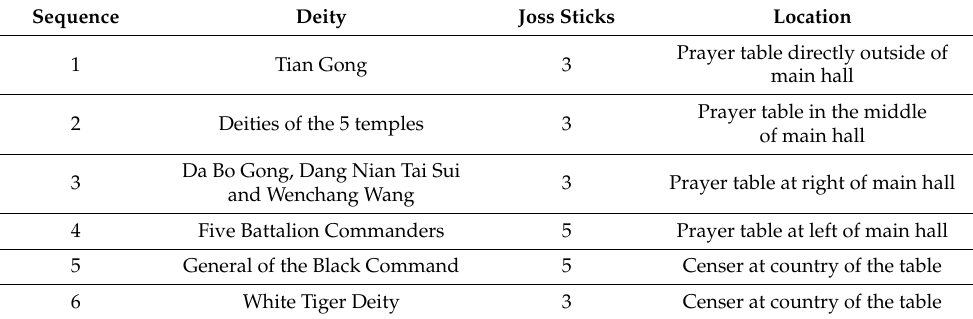
Table 6. The order of prayers in the five Nan’an( 南 安 ) temples.